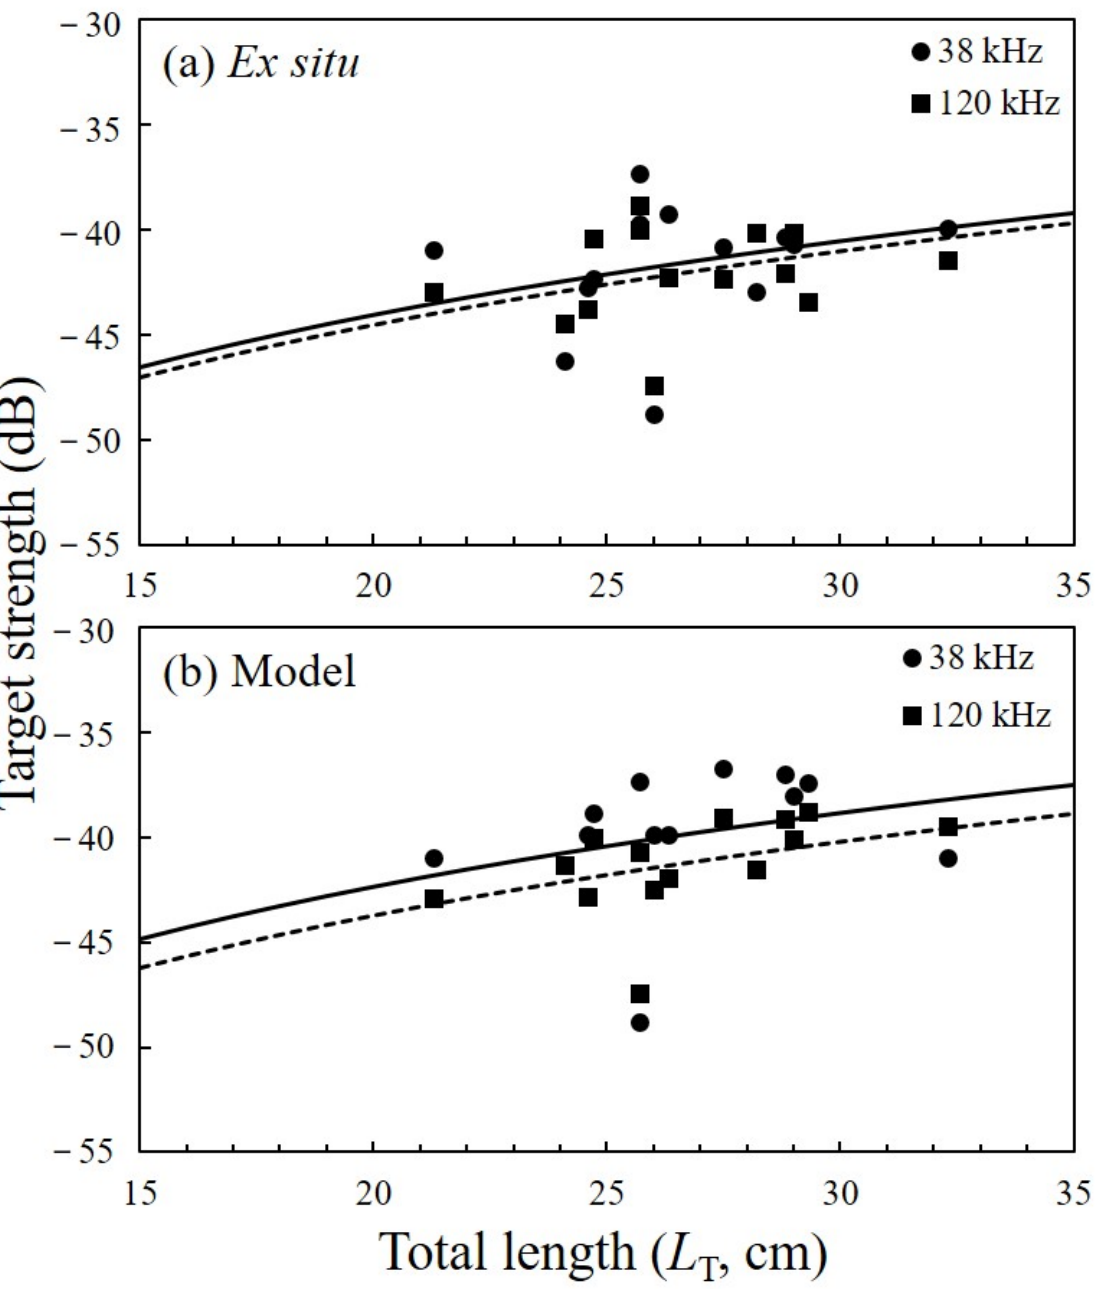
Figure 7. The TS– L T relationships of the regression equations (20 log 10 ( L T ) + b 20 ) at 38 (solid line) and 120 kHz (dashed line) using the ( a ) ex-situ and ( b ) theoretical model methods.